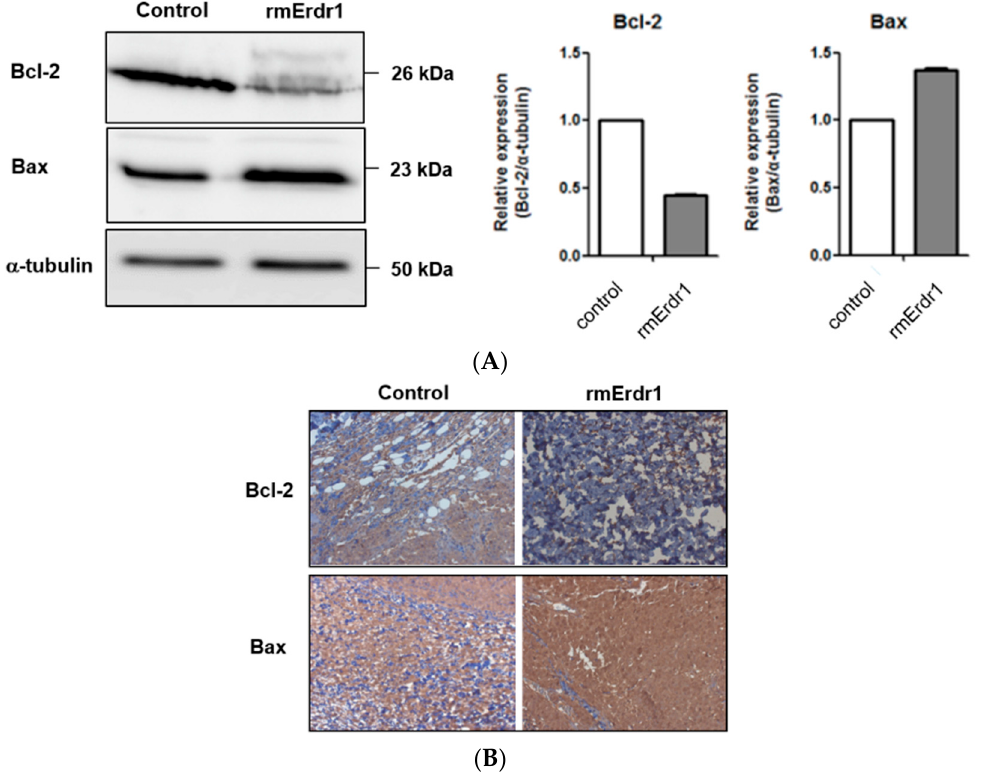
Figure 2. Erdr1 suppresses Bcl-2 and induces Bax in vivo . ( A ) Tumor tissues were lysed, and identical amounts of lysate were loaded onto an acrylamide gel. Western blotting was performed using rabbit anti-mouse Bcl-2 antibody, rabbit anti-mouse Bax antibody, and mouse anti- α -tubulin antibody; ( B ) Bcl-2 and Bax levels in tumor tissues were measured using immunohistochemistry. Sections from tumors were stained with rabbit anti-mouse Bcl-2 antibody and rabbit anti-mouse Bax antibody. (100×).